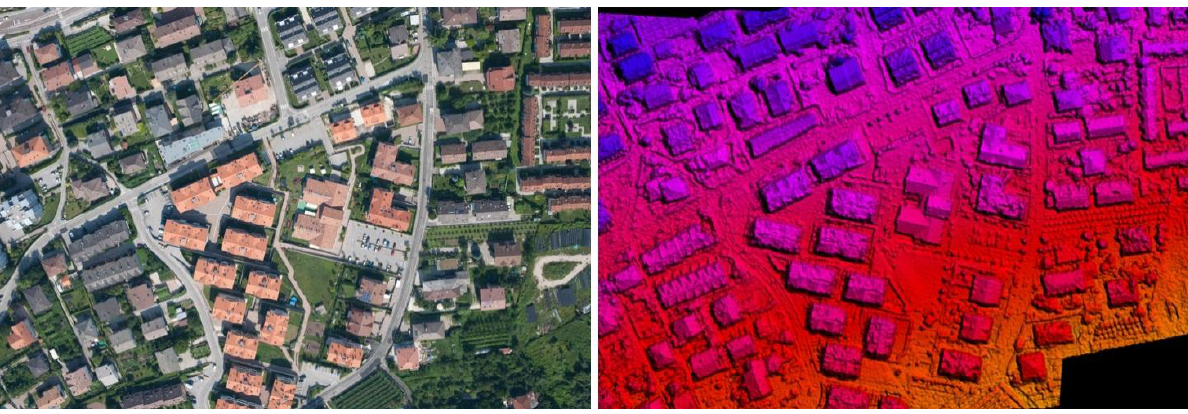
Figure 3. Automated DSM generation (25 cm geometric resolution) from aerial images acquired with a SLR camera from a helicopter (10 cm